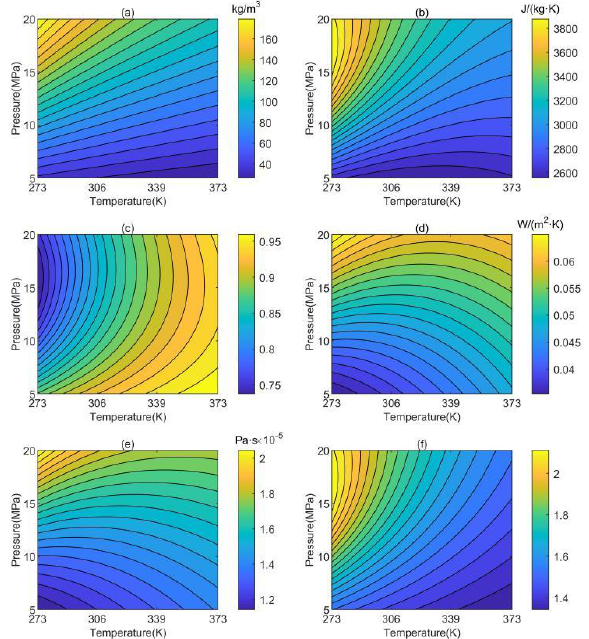
Figure 5. Thermophysical properties of methane at temperatures ranging from 273 to 373 K and pressures ranging from 5 to 20 MPa: ( a ) density, kg/m 3 ; ( b ) isobaric heat capacity, J/(kg · K); ( c ) compressibility factor (Z); ( d ) thermal conductivity, W/(m · K); ( e ) viscosity, Pa · s; ( f ) specific heat capacity, J/(kg · K).